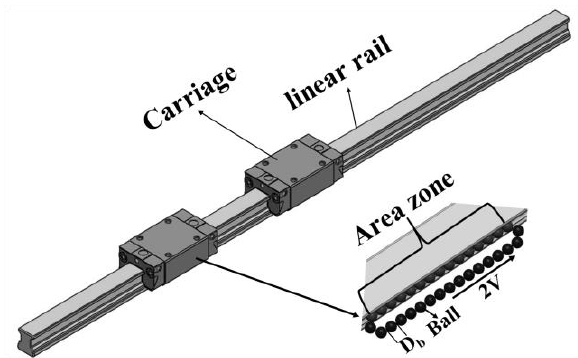
Fig. 4 Component and ball element of linear bearing.